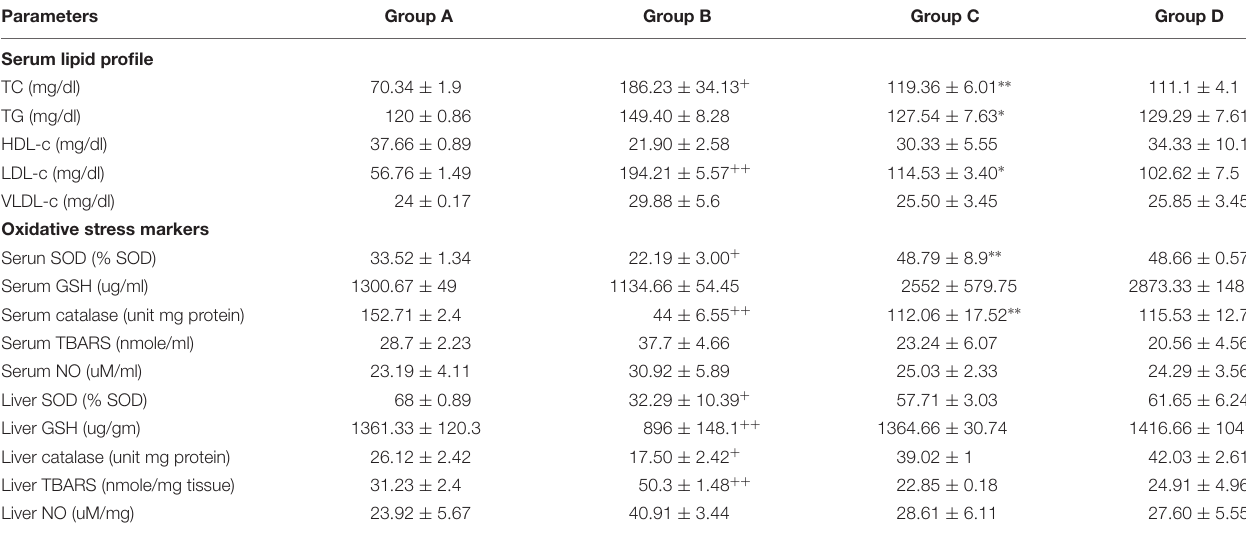
TABLE 1 | Changes in levels of serum lipid profile (TC, TG, HDL-c, LDL-c, and VLDL-c) and oxidative stress markers (SOD, GSH, Catalase, TBARS, and NO) in serum and liver in groups A, B, C, and D.